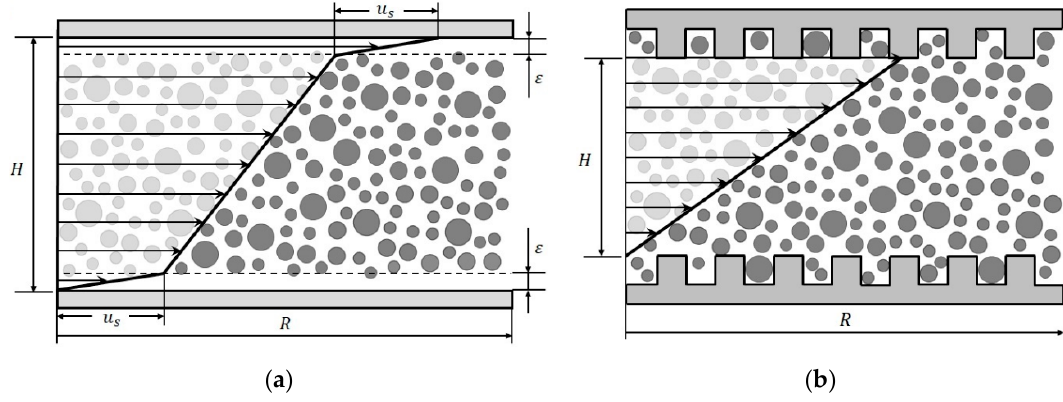
Figure 1. Schematic illustration of the velocity profile in a parallel-plate system (gap height H , plate radius R ); ( a ) showing wall slip (slip velocity u S ) with the particle-depleted area ε ; ( b ) with grooved surface to prevent wall slip.